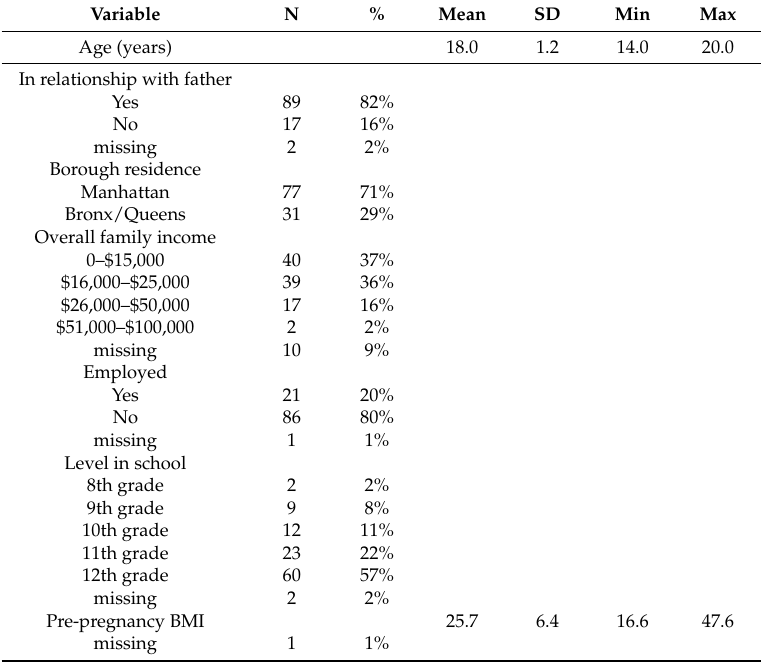
Table 1. Demographic, health, and psychosocial characteristics of the study population: 108 pregnant Latina adolescents from New York